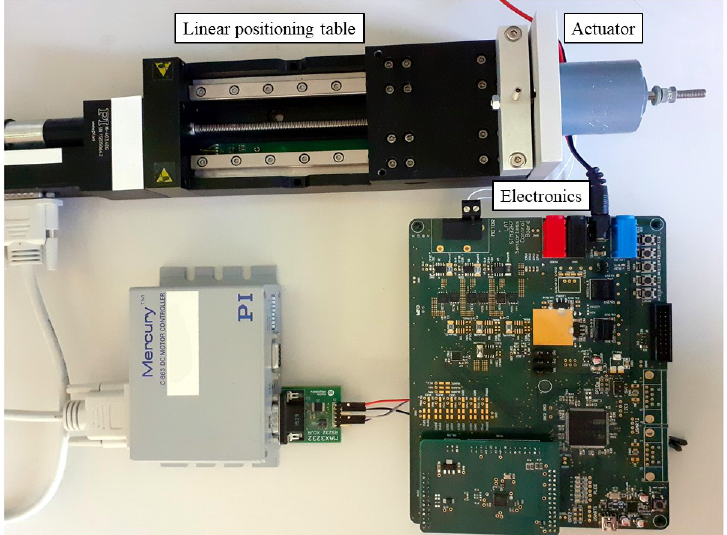
Figure 12. Experimental setup showing the actuator under test, the microcontroller-based electronics implementing the proposed approach, and the linear positioning table.